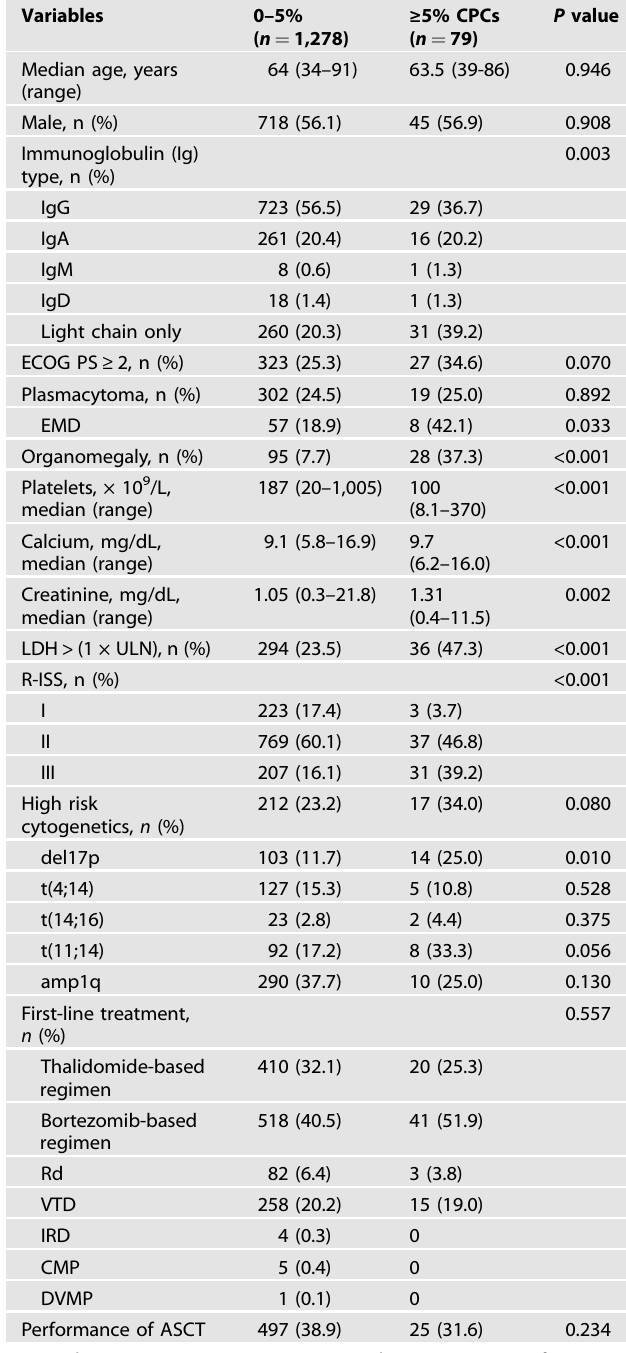
Table 1. Baseline clinical characteristics based on circulating plasma cells (CPCs) ( n =